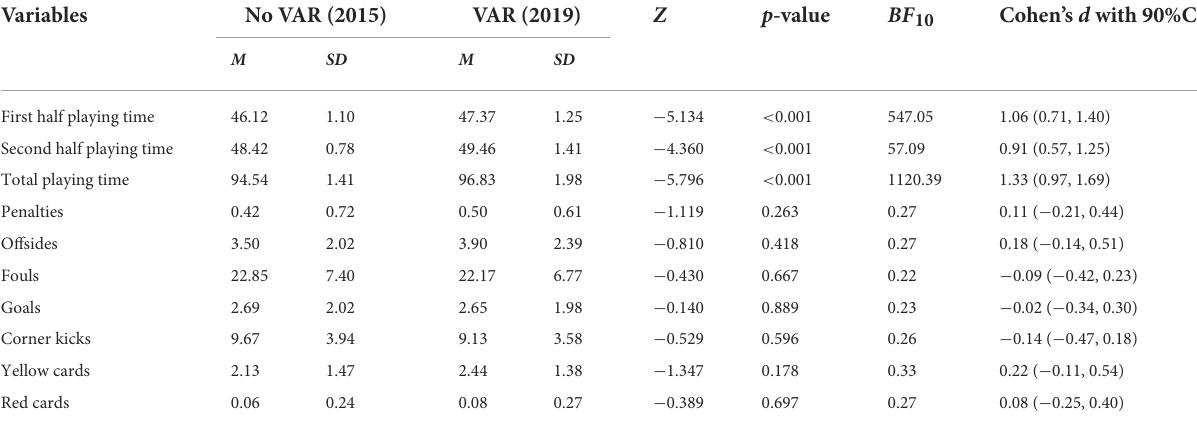
TABLE 1 Descriptive statistics and results of Mann–Whitney U test and Bayesian analysis for match variables without VAR (2015) and with VAR